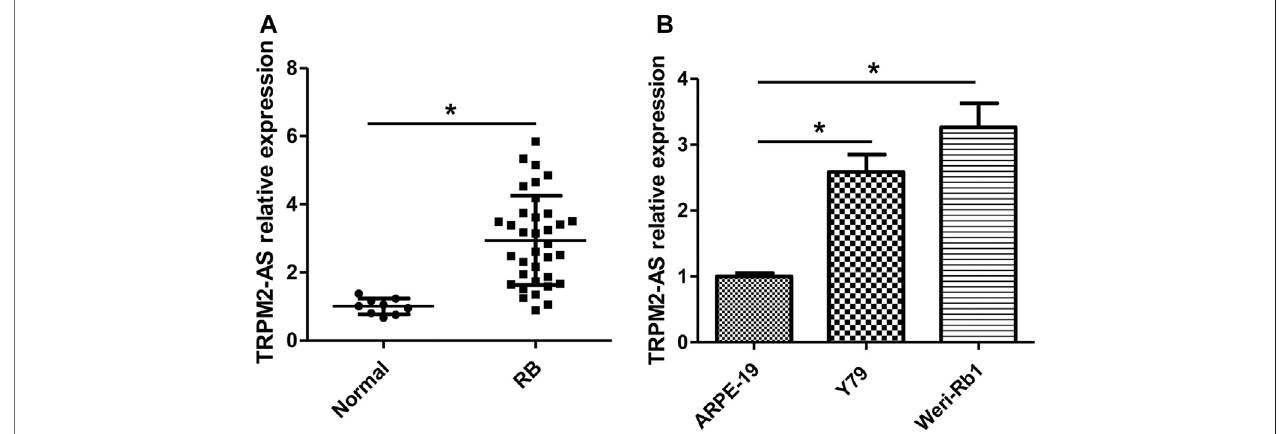
FIGURE1| TRPM2-ASexpressionisincreasedinhumanRBtissuesandcells. (A) Real-timePCRwasusedtomeasuretherelativeexpressionofTRPM2-ASin35 RB and nine normal tissue samples. (B) The relative expression of TRPM2-AS was higher in Y79 and Weri-Rb1 cells than ARPE-19 cells. * p < 0.05.